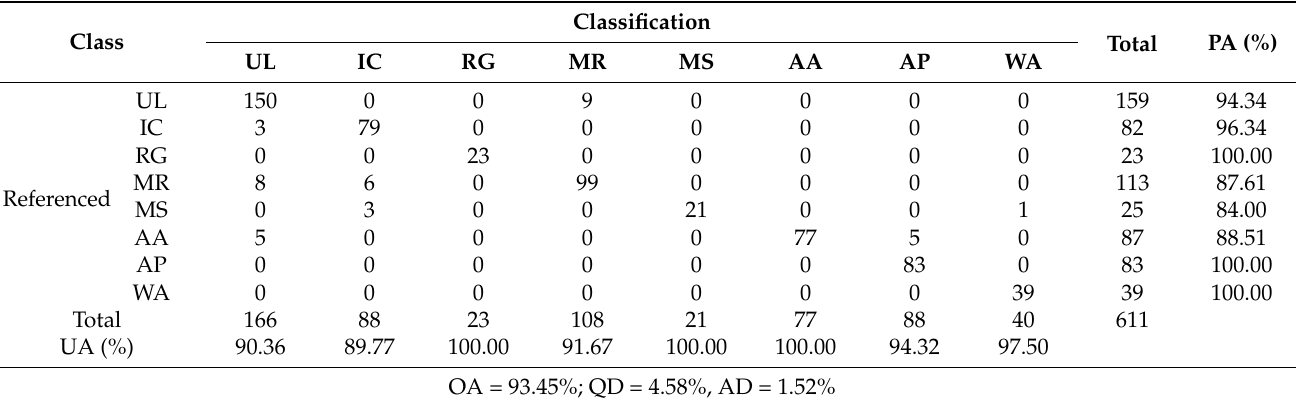
Table 5. Confusion matrix of the final land use map.